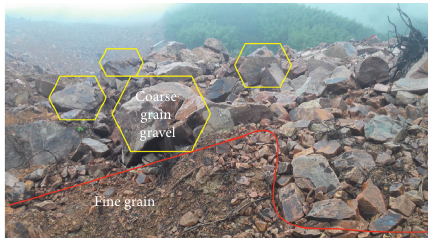
Figure 9: The deposition area is composed of large blocks having a binary structure. View of the rockslide deposits showing the upper slope composed of coarse grain gravel and fine-grain debris flow deposit located